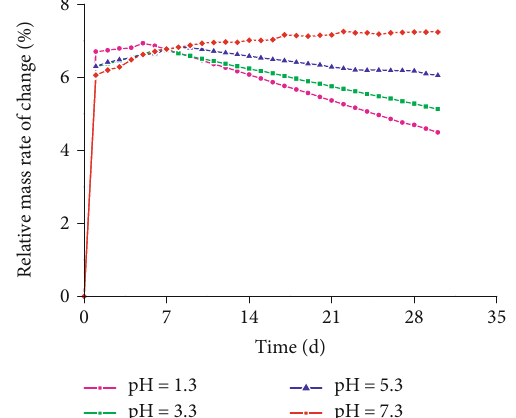
Figure 2: Change rate of relative mass of sample with soaking